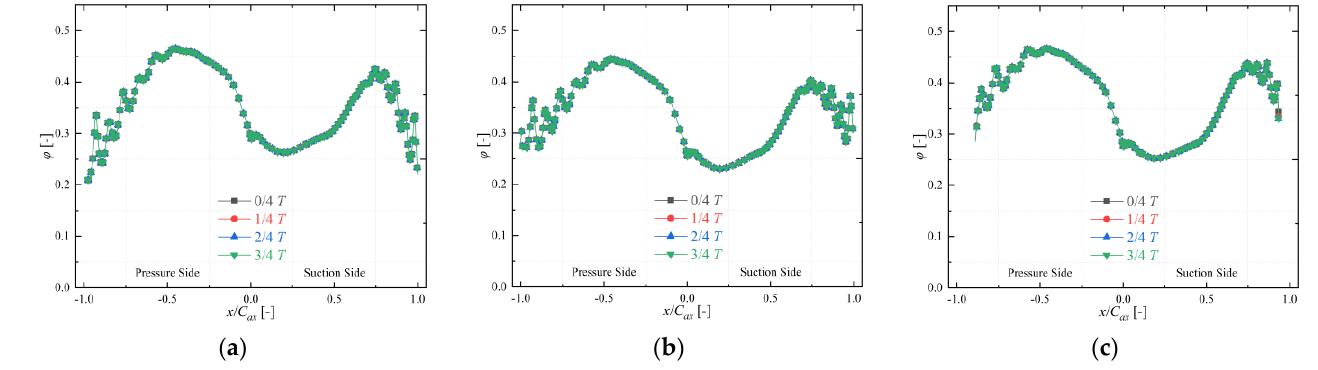
Figure 9. The overall cooling effectiveness distribution along the stator vane surface. ( a ) At 25% span; ( b ) at 50% span; ( c ) at 75% span.